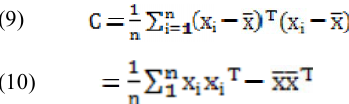
Table 1 . HLA Protien Sequences fpr CLASS I